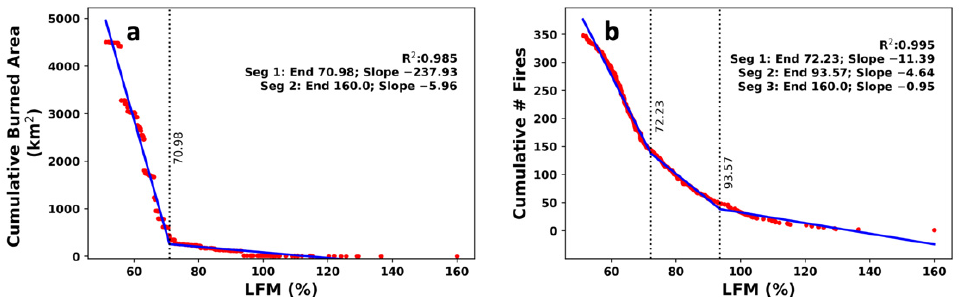
Figure A1. LFM of ( a ) observed in situ LFM v. cumulative burned area, and ( b ) observed in situ LFM vs. cumulative number of fires.